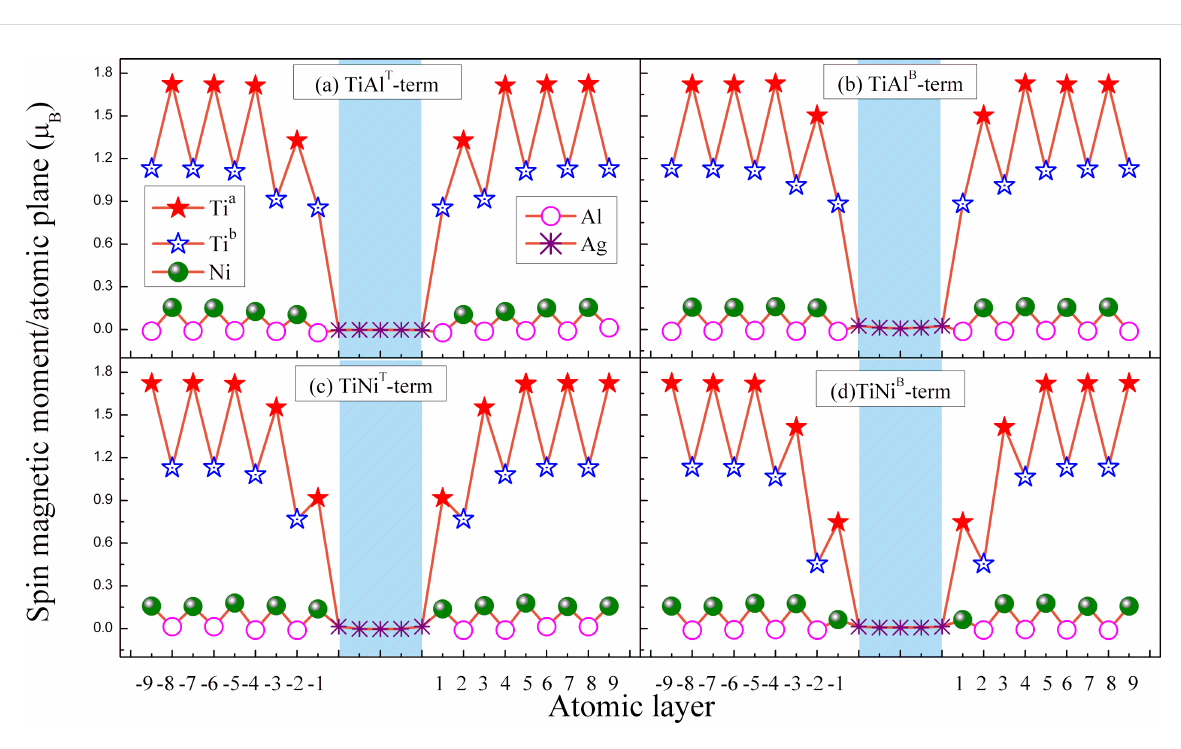
Figure 2: The calculated atomic spin magnetic moment of Ti 2 NiAl/Ag/Ti 2 NiAl CPP-SV at different atomic layers. (a) TiAl T -terminated structure, (b) TiAl B -terminated structure, (c) TiNi T -terminated structure and (d) TiNi B -terminated